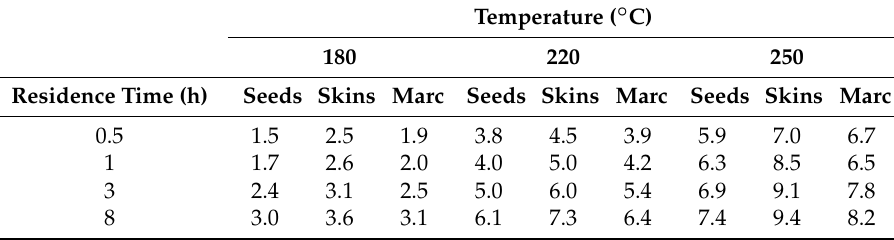
Table 4. Gas yields (mass of gas formed divided by the mass of initial dry feedstock,